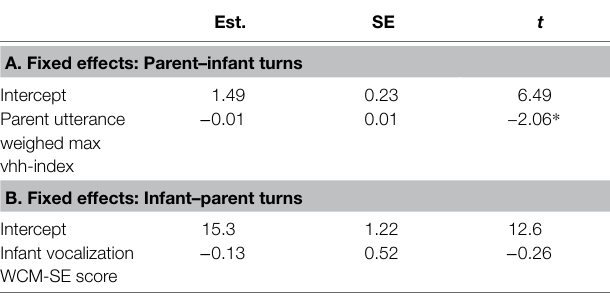
TABLE 9 | Summary of the fixed effects of the analysis of the measure weighted max vhh-index in parent–infant turns (A) and infant–parent turns (B). According to the t-as-z approach to estimate statistical significance (thresholds ±1.96; Luke, 2017), the effect of weighted max vhh-index in the parent utterance can be considered significant in infant–parent turns (marked by an